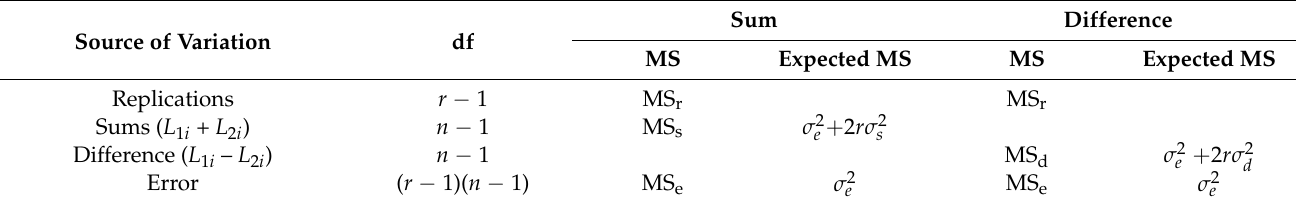
Table 1. Analysis of variance for estimation of the additive and dominance